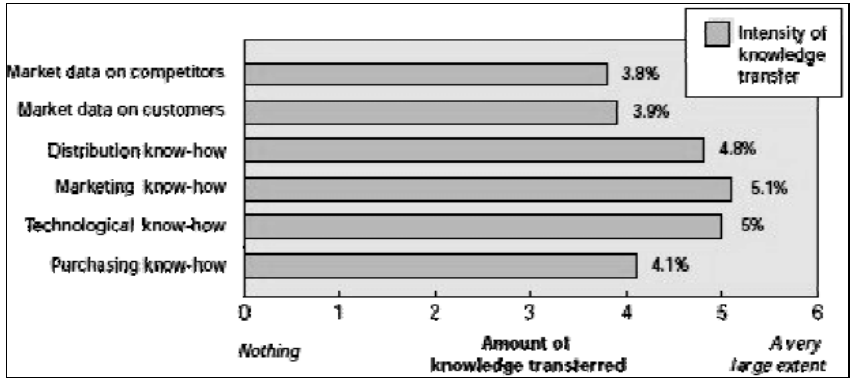
Figure 1: Intensity of Reverse Knowledge Transfers by Knowlwdge Type